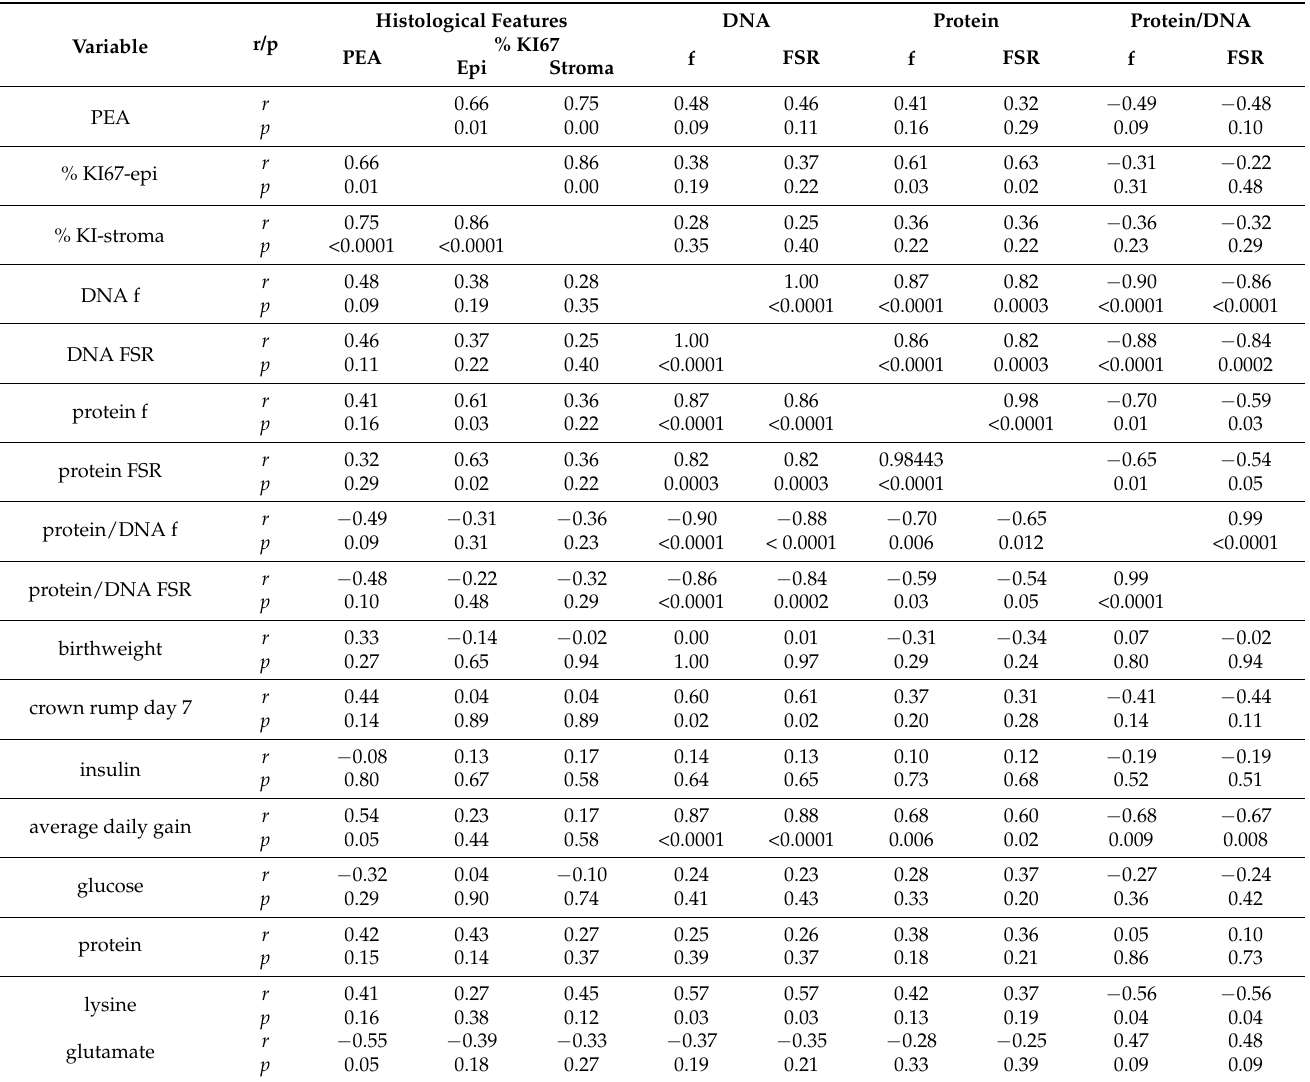
Table 5. Correlation analysis of the relationship between corollaries of perinatal nutrition (plasma concentration of insulin, protein, glucose, lysine and glutamate at 24 h postnatal; birth weight, crown rump length on postnatal day seven, and average daily gain between birth and day seven) and variables used to evaluate mammary